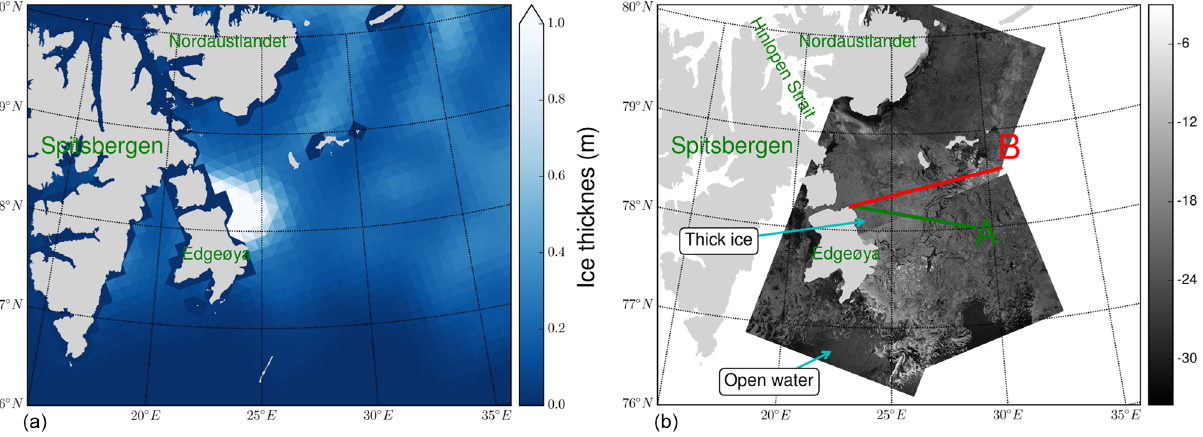
Figure 1. The region of the SMOSice 2014 campaign. (a) Sea ice thickness on 24 March 2014, derived from SMOS. The SMOS sea ice thickness product with a resolution of 40km is presented on a 15km grid. An aggregation of thick ice ( > 1m) is visible along the Edgeøya’s eastern coast. (b) The TerraSAR-X wide-swath mode (HH polarisation), with frames taken at 05:35 and 14:58UTC. The aircraft tracks are marked in green (A) at 10:05–10:41UTC and red (B) at